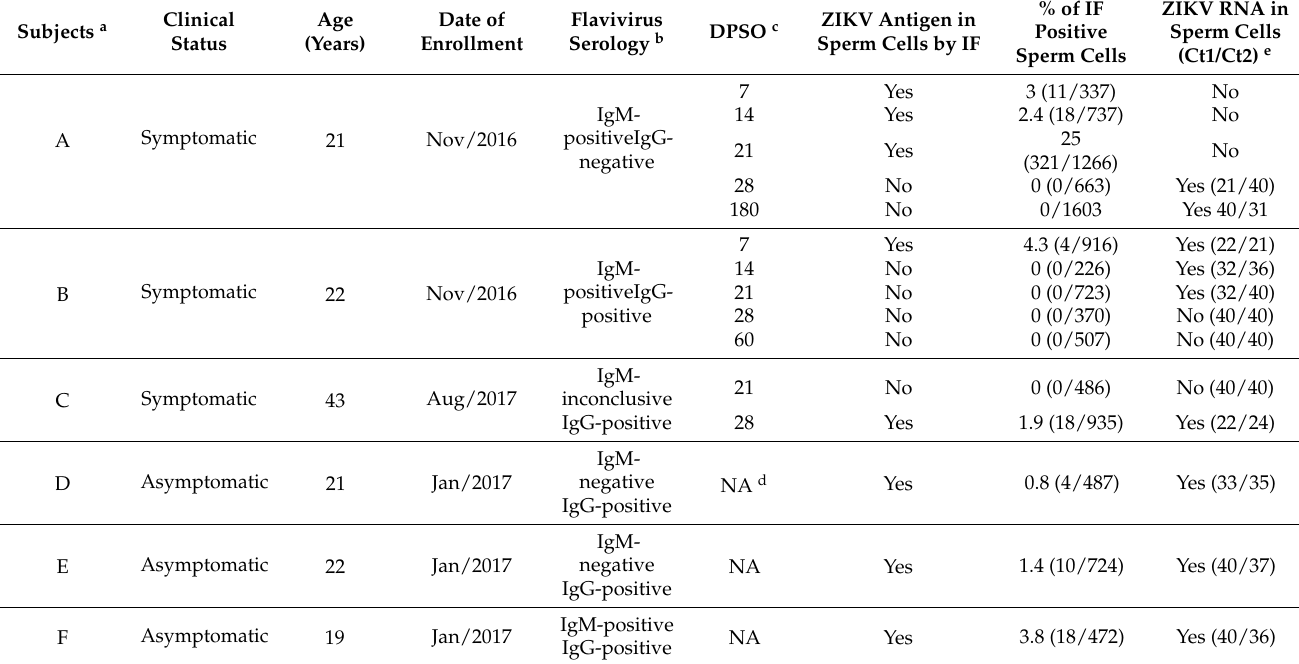
Table 1. Description of the clinical status and detection of Flavivirus antigens and RNA in spermatozoa from subjects exposed to the virus during the emergency in Nicaragua in